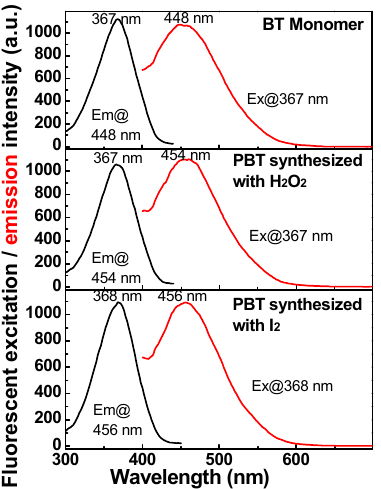
Figure 9. Fluorescent excitation and emission spectra obtained at fixed slit widths of 5 nm of 100 μ g L − 1 BT and PBT solutions in N -methy1-2-pyrrolidone (NMP).